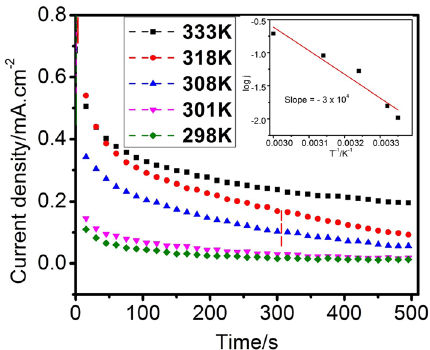
Fig. 10 CV curves of Ag/C-20 at different temperatures at 0.2 V in 0.5 M NaOH + 0.01 M NaBH . Inset shows the corresponding plot of 4 log j vs